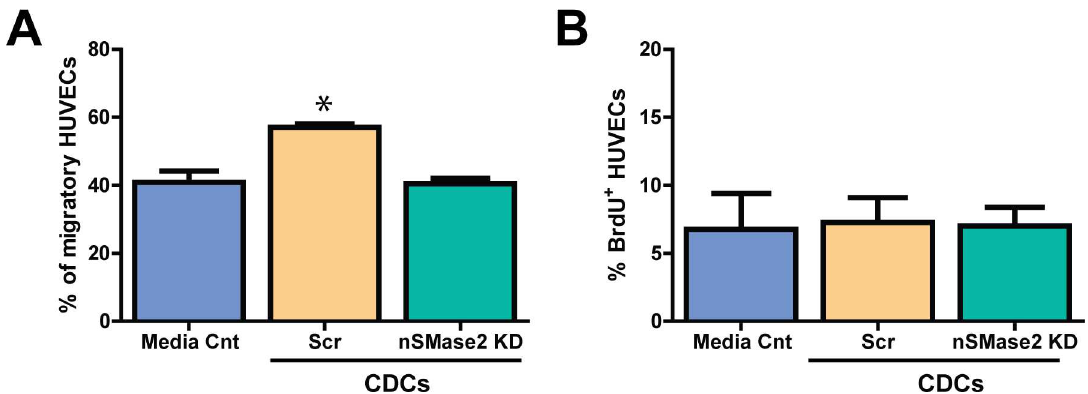
Fig 6. hCDC-derived exosomes promote HUVEC migration without affecting proliferation. (A) The migratory response of HUVECs followinghCDC coculture was studied using a 4 hour transwell migrationassay. HUVECs cocultured with lentiviral Scrambled control (Scr) CDCs had increasedmigration as hen compared to endothelial cells coculturedwith lentiviral:nSMase2 KD CDCs (57 vs 41%) and media control (n = 3). (B) HUVECs cocultured with Scr CDCs and pulsedwith BrdU demonstrated no changein proliferation compared to those cocultured with nSMase2 KD CDCs (% BrdU+ cells/total number of DAPI+ cells; n = 3). * p < 0.05 by one-way ANOVA (Tukey’s post hoc test). Data are presented as mean ±